Question: Draft a figure caption describing what is shown.
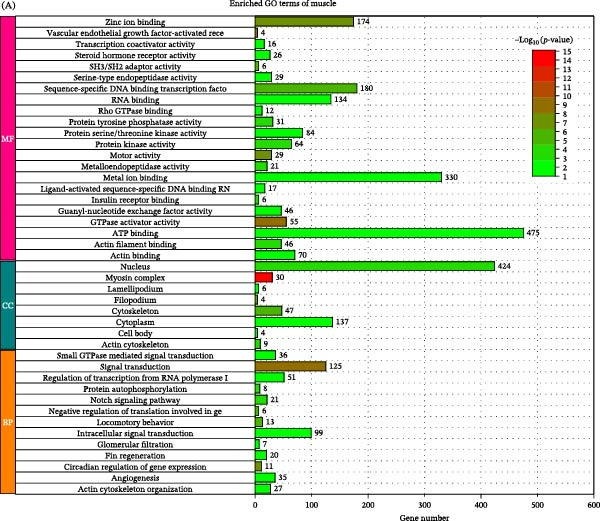
Answer: GO classification of all DEGs in muscle and liver of hybrid grouper. (A) Enriched GO terms of muscle and (B) Enriched GO terms of liver. BPs: biological processes; CCs: cellular components; MFs: molecular functions.